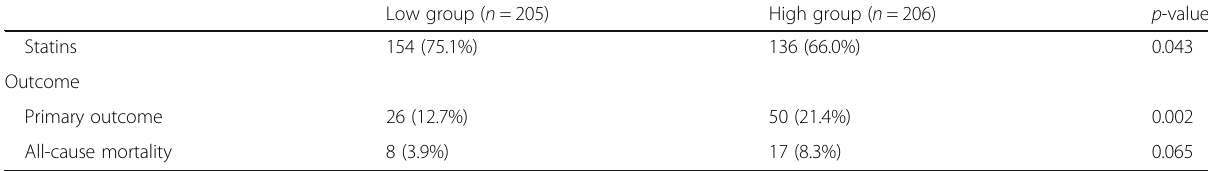
Table 1 Baseline characteristics of the AHF cohort ( n = 411) (Continued)